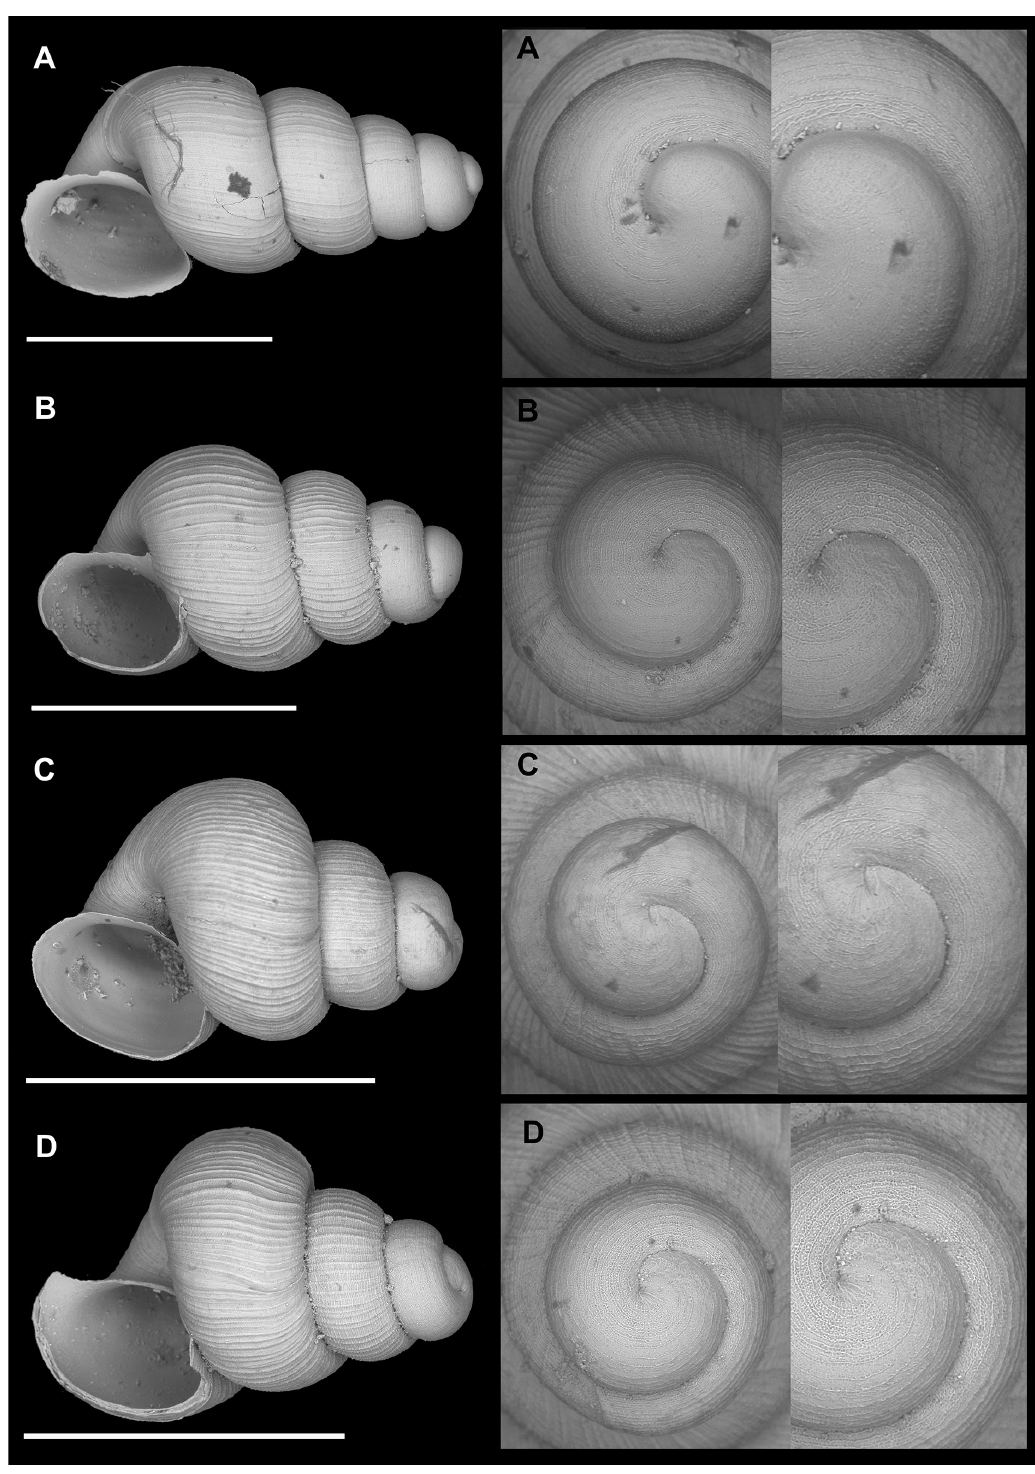
Fig. 10. A . Plagigeyeria erossi sp. nov., Donja Jablanica, Komadinovo Vrelo, paratype (SBMNH 632010). B . P. listicaensis sp. nov., Široki Brijeg, Vrelo Lištice, Bilo Vrilo, paratype (SBMNH 626350). C . P. olsavskyi sp. nov., Studenci, Vrilo Kajtazovina, paratype (SBMNH 626245). D . P. olsavskyi sp. nov., Ljubuški, spring Mali Prokop, paratype (SBMNH 626260). Scale bars = 1 mm (SEM SBMNH Vanessa